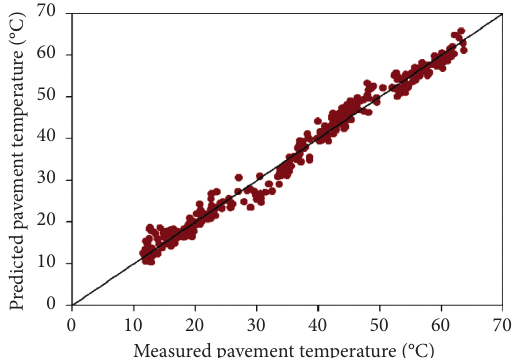
Figure 9: Measured versus predicted maximum temperature at 2cm depth in 2017.